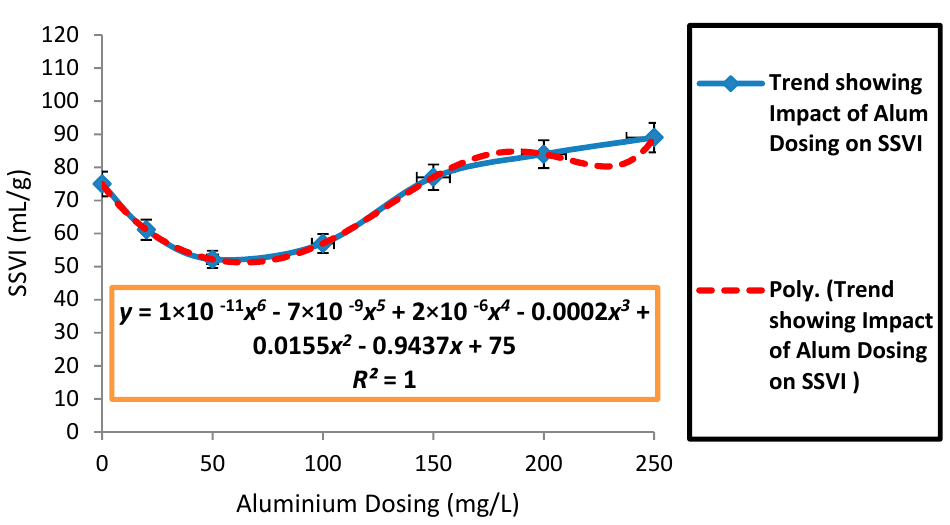
Figure 4. The impact of Al dosing (mg/L) on SSVI (mL/g) (error bars represent standard deviation of the mean).